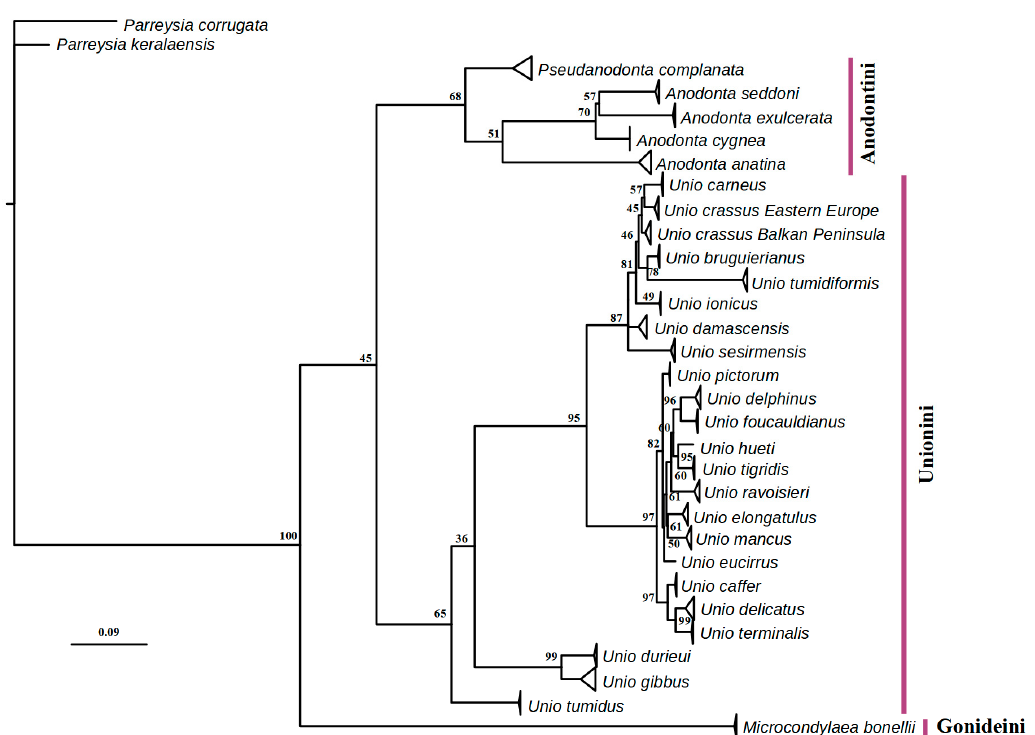
Figure 7. Maximum likelihood phylogeny of freshwater mussels (Unionidae) from Montenegro and adjacent countries with supplement of related taxa based on the COI barcode fragment. Black numbers near nodes are BS values.